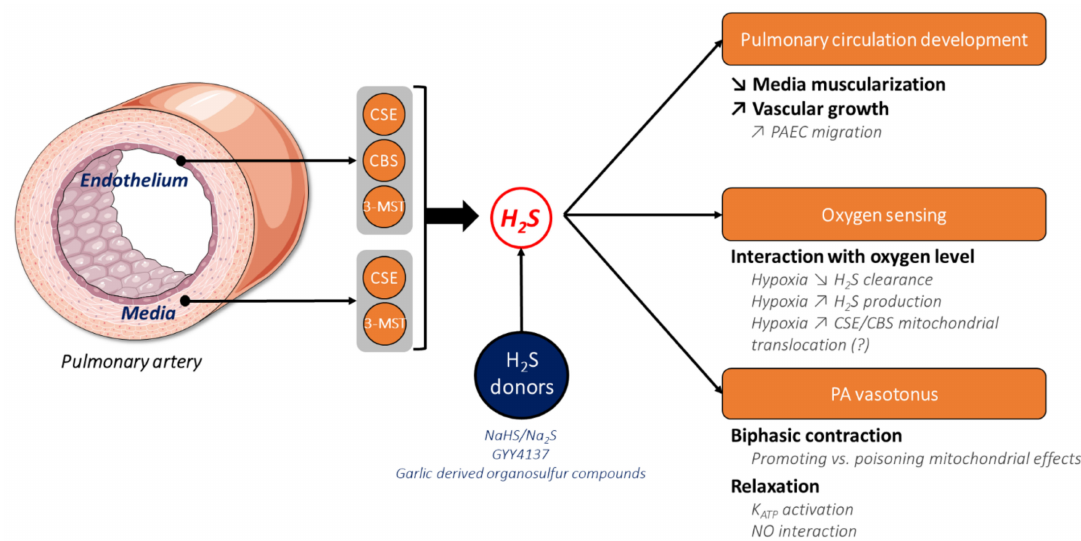
Figure 3. Endogenous production of H 2 S and its roles in pulmonary circulation. H 2 S-producing enzymes have been found to be expressed in the endothelium and the media of pulmonary arteries. CSE and 3-MST are detected in both PAECs and PASMCs, whereas CBS exhibits an endothelial predominance. H 2 S is involved in lung and PA development by (1) promoting vascular growth and associated PAEC migration and (2) decreasing media muscularization. Variation in the partial pressure of oxygen is linked to regulation of H 2 S metabolism. Hypoxia exposure triggers a decrease in H 2 S clearance and an increase in H 2 S production, leading to a global elevation of intracellular H 2 S levels. Modulation of the H 2 S clearance/production balance may play a pivotal role in oxygen sensing in pulmonary circulation. PA treatment with H 2 S donors is associated with paradoxical influence on vascular tone. On the one hand, H 2 S induces biphasic contraction of PAs that could be explained by the balance of the promotion (oxidation by SQR) versus poisoning (blocking of complex IV) effects of H 2 S on mitochondrial ETC function. In other hand, H 2 S also dose-dependently relaxes PAs through the activation of K ATP channels, leading to vascular cells’ hyperpolarization and, thus, to relaxation. Crosstalk between H 2 S and endothelial NO pathways was also observed, suggesting a potential role of the endothelium in the relaxing effects of H 2